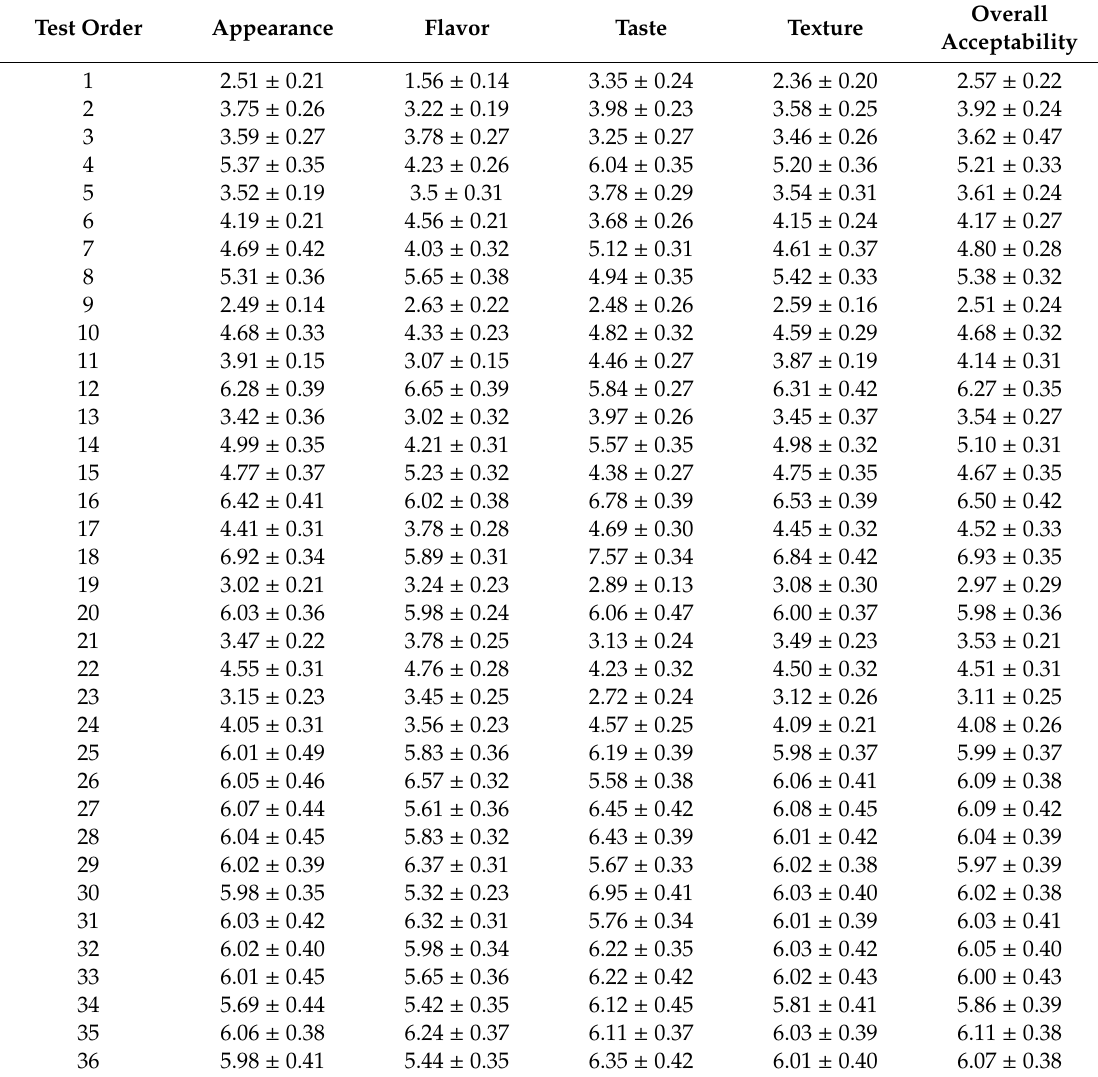
Table A3. Sensory evaluation scores of the 3D-printed